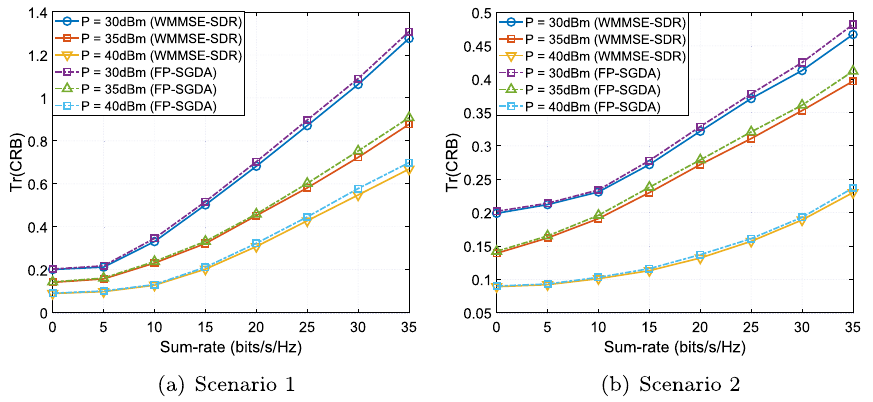
Fig. 4 Comparison of Tr(CRB) of WMMSE–SDR and FP‑SGDA algorithms